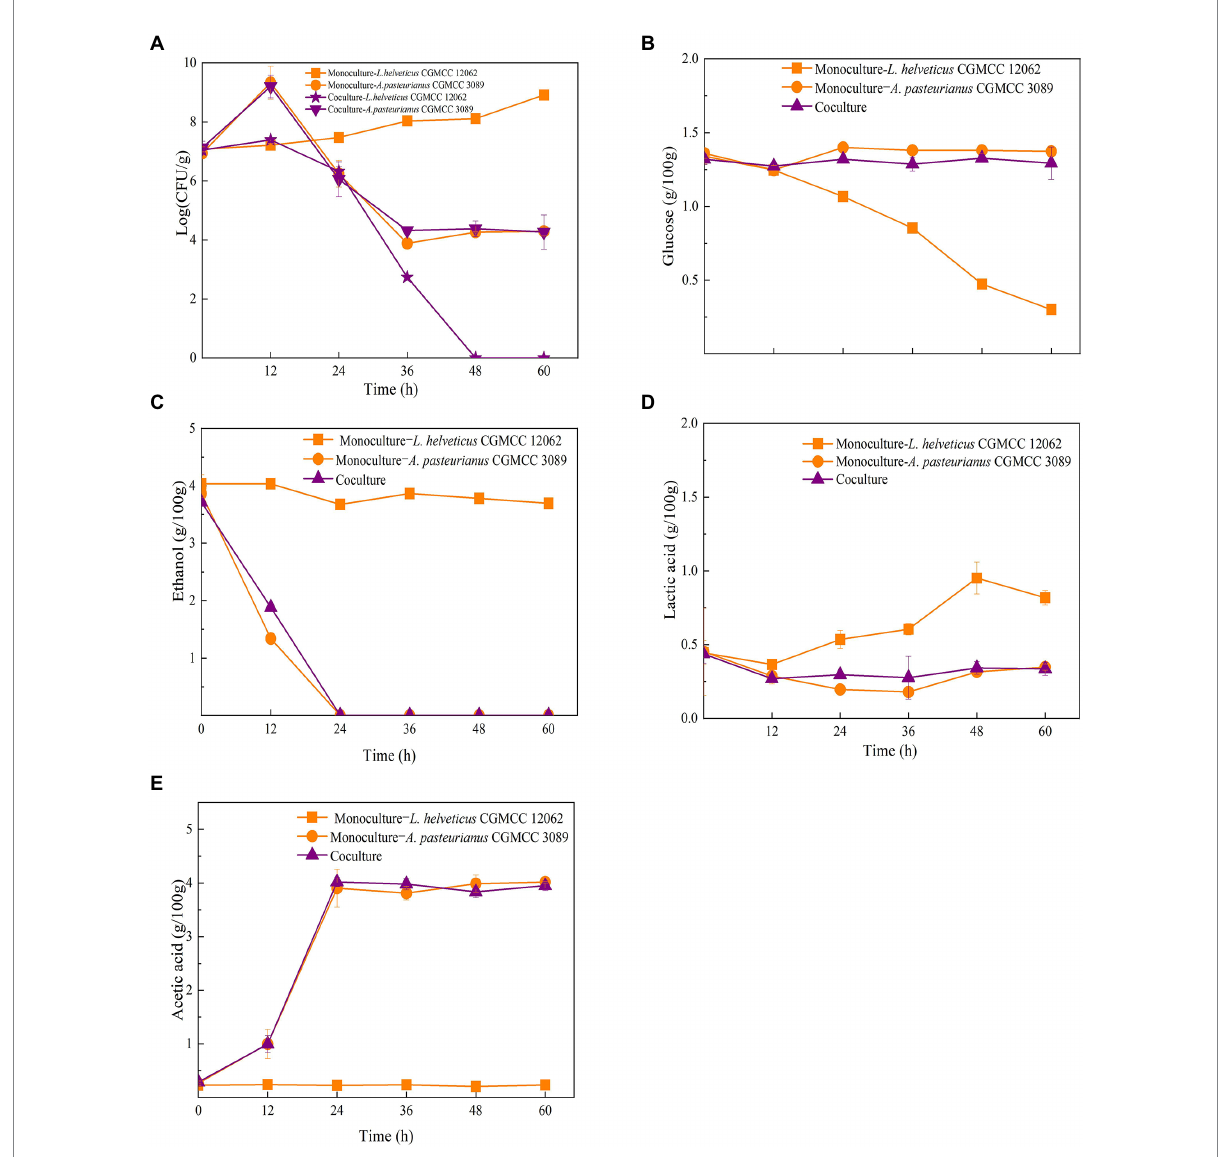
FIGURE 2 Time curves in mono-culture and co-culture of L. helveticus and A. pasteurianus . (A) Cell growth; (B) Glucose consumption; (C) Ethanol consumption; (D) Lactic acid production; (E) Acetic acid